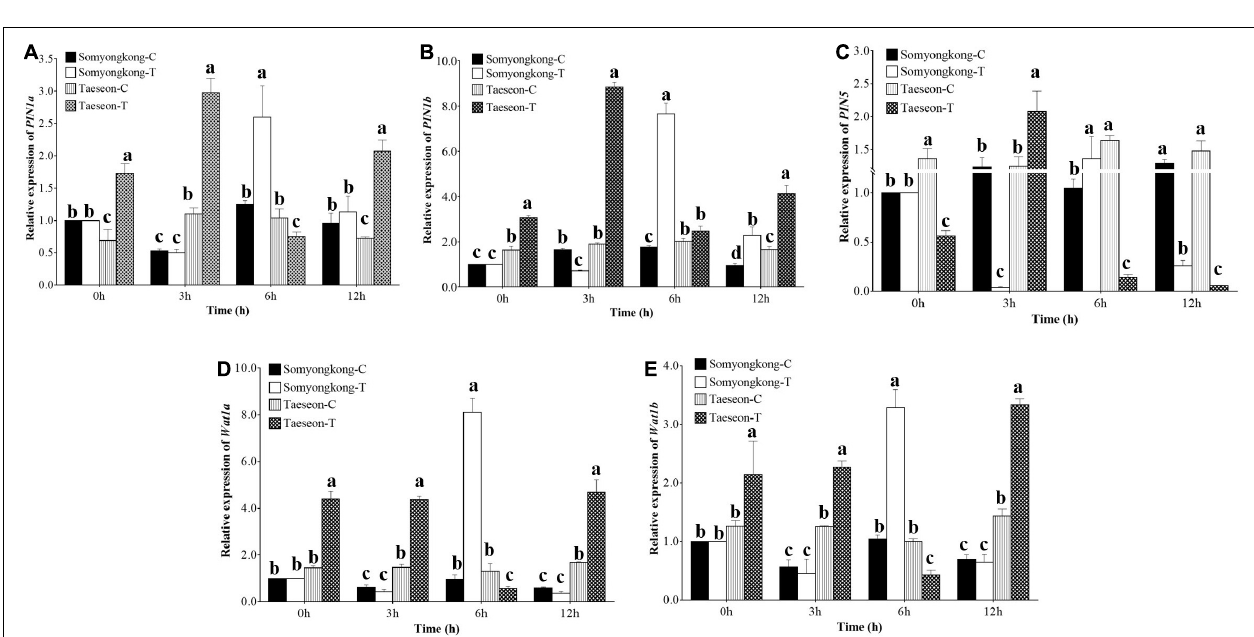
FIGURE 8 | Relative expression levels of root development and auxin biosynthesis pathway genes. Expression levels of YUC3, (A) YUC5-1, (B) YUC5-2, (C) YUC6, (D) YUC7, and (E) , genes in the roots of control (C) and Si-treated (T) Somyongkong and Taeseon cultivars at different periods. All the values are mean ± SE ( n = 3). Error bars indicate a standard error and different letters indicate the significant difference ( P < 0.05) between treatments using the T -test.